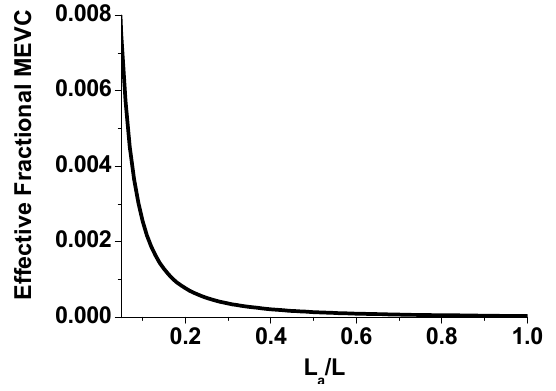
Figure 9. Effective fractional ME voltage coefficient (MEVC) as a function of L a /L for an assembled film of fibers of sample A. L a is the air gap in a fiber of length L .